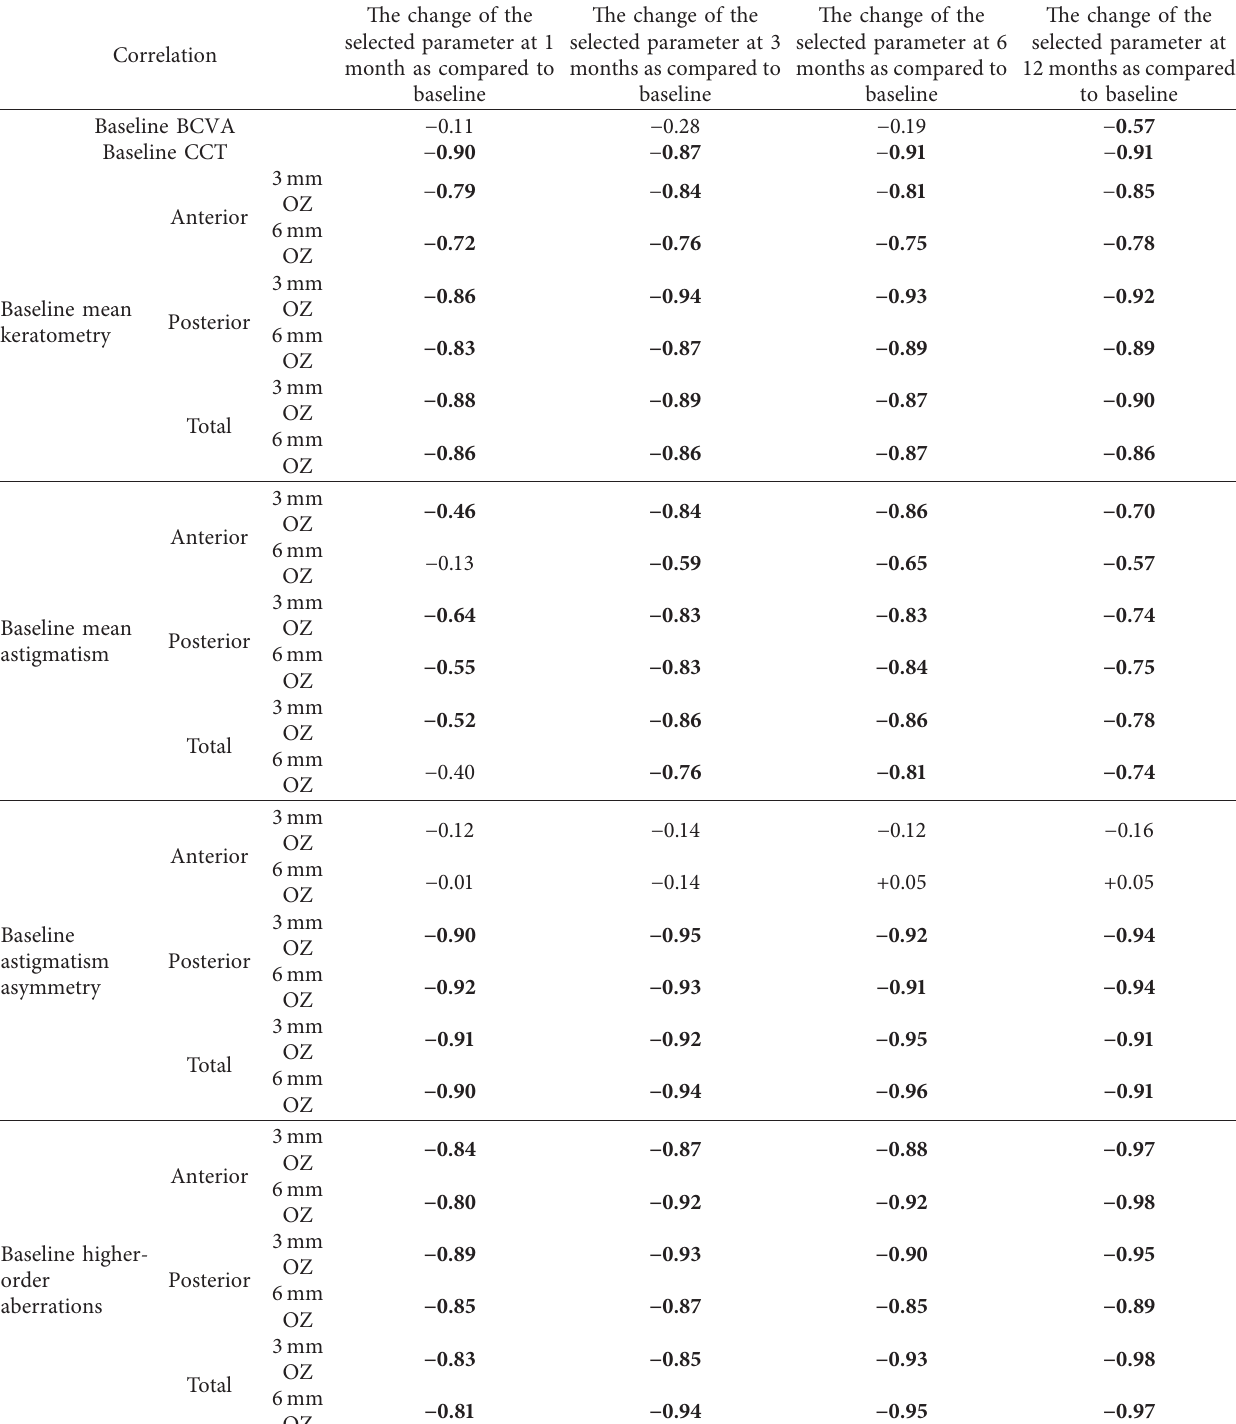
Table 3: The correlations between changes in VA, CCT, keratometry, astigmatism, astigmatism asymmetry, and higher-order aberration and baseline values of those parameters.